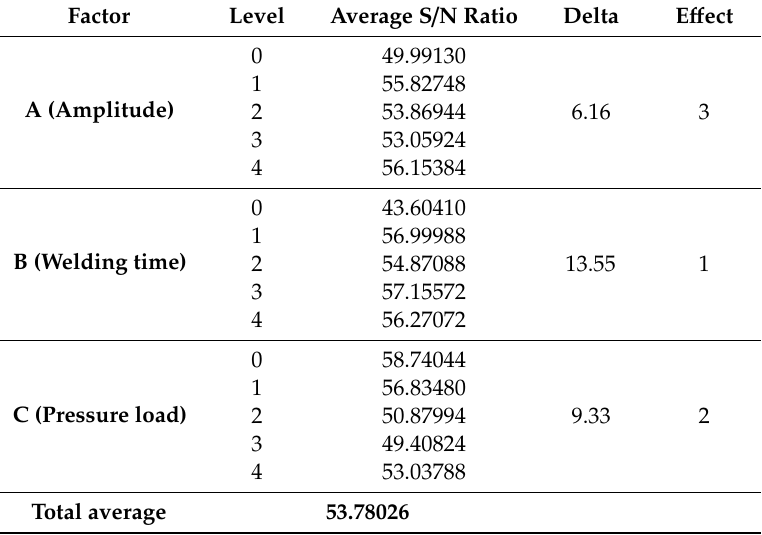
Table 5. Welding parameters and conditions corresponding to the factors and levels.